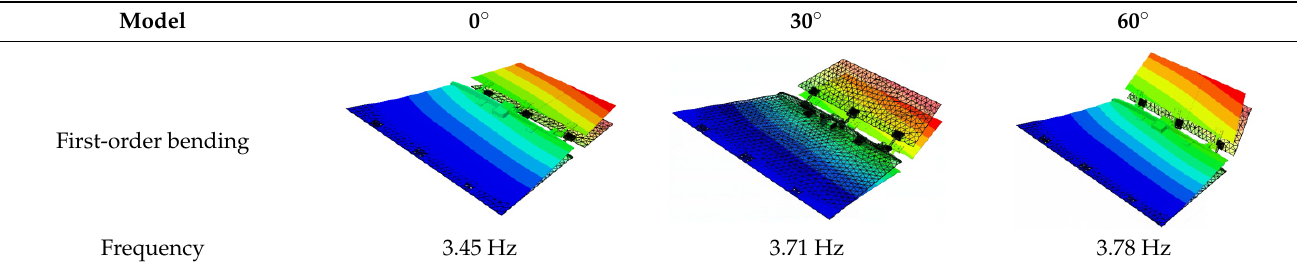
Table 4. Finite element model simulation.